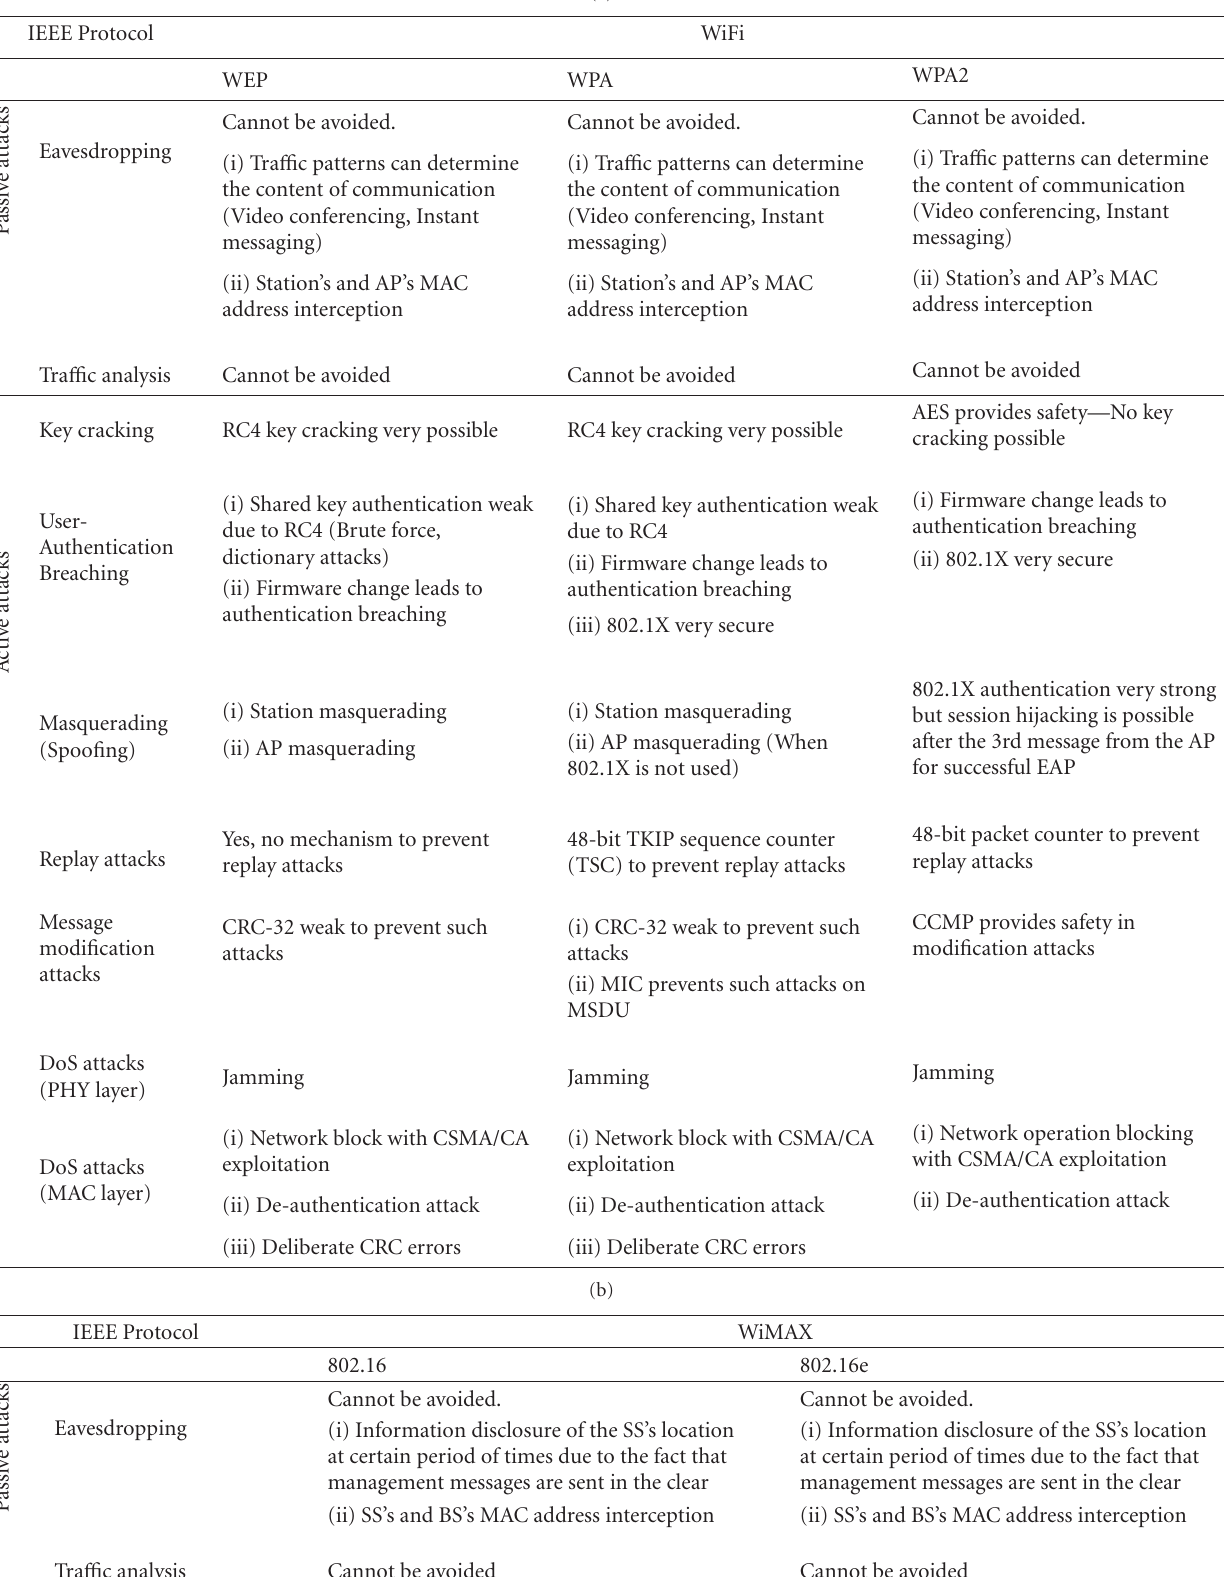
Table 2: WiFi and WiMAX threat analysis comparative